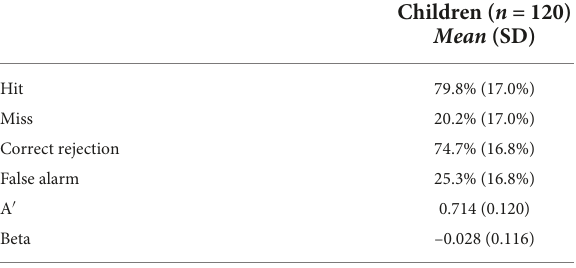
TABLE 1 Descriptive statistics children’s categorization scores.